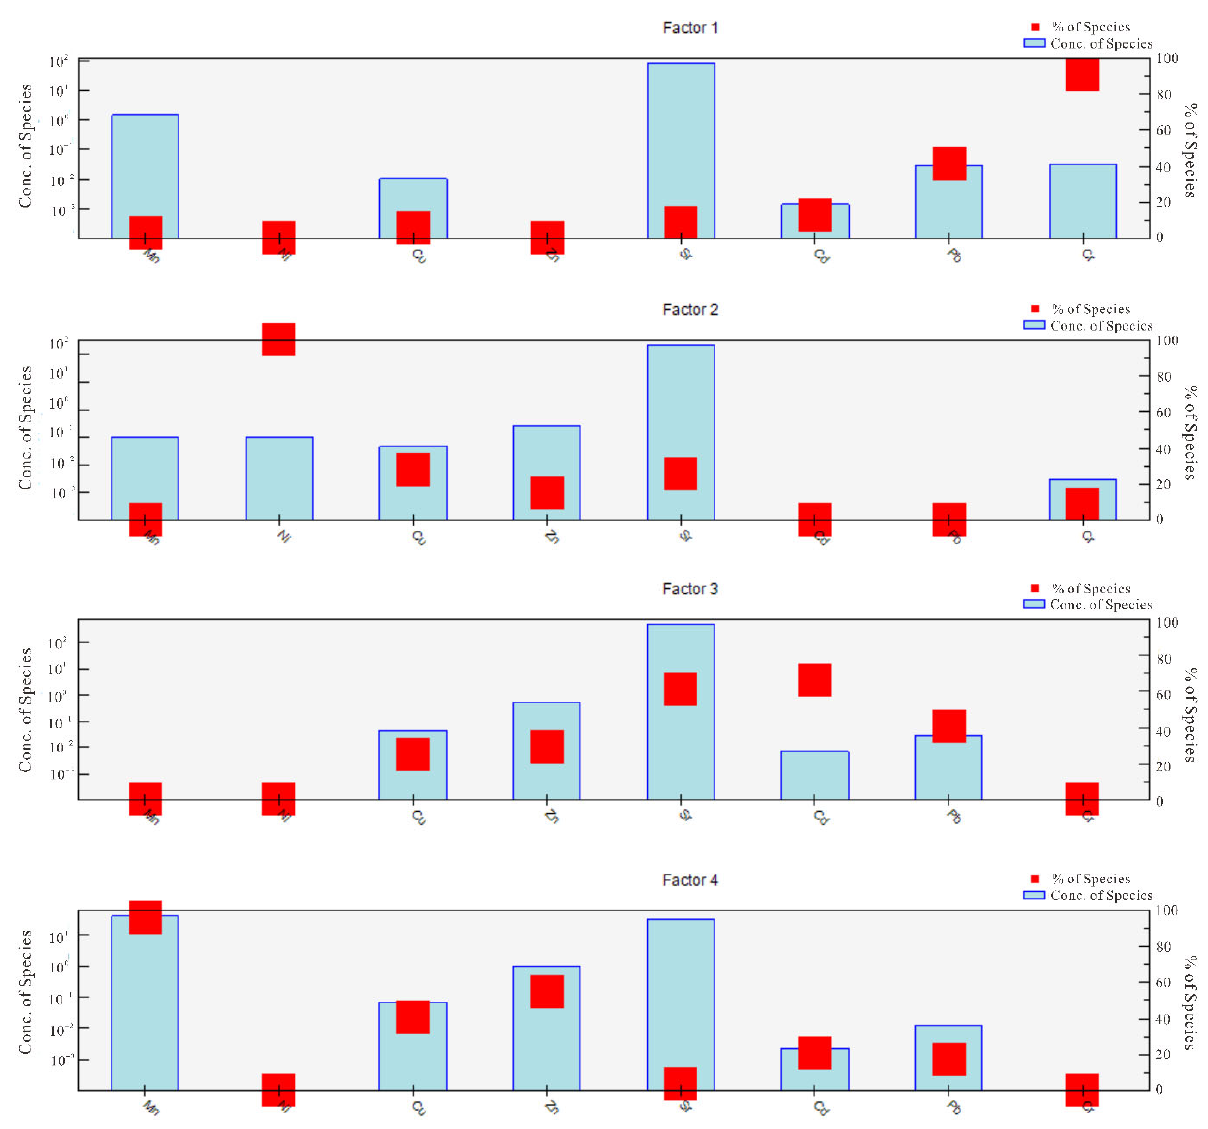
Figure 5. Contribution profile of each factor to heavy metal pollution.